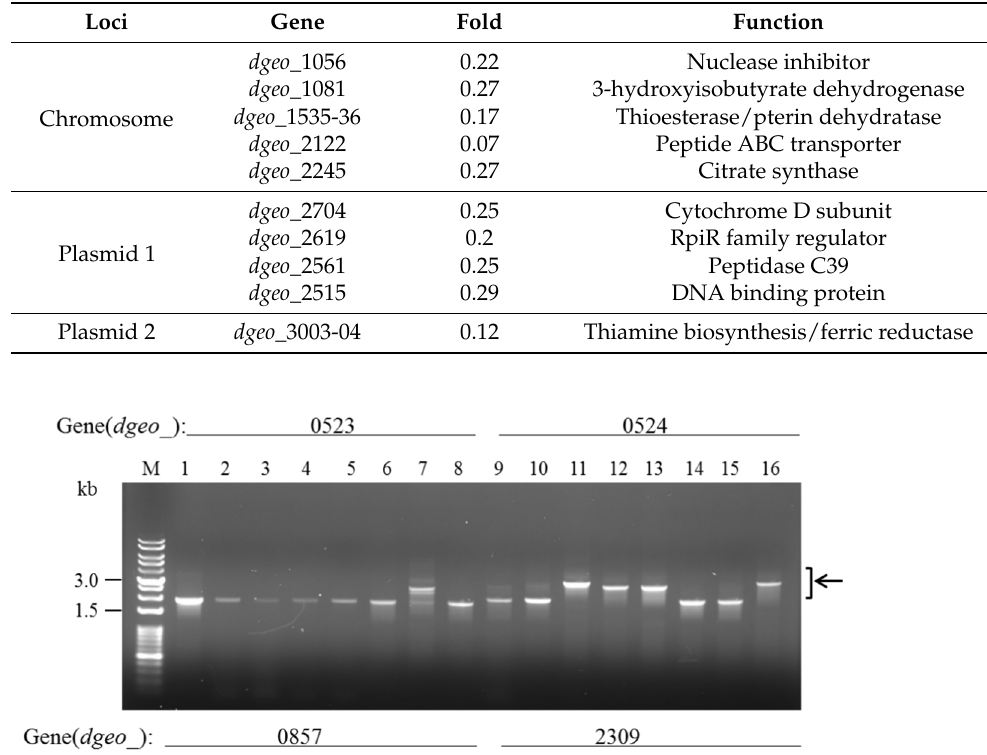
Table 2. List of down-regulated genes (<0.3-fold decrease) in the cystine importer-disrupted mutant.